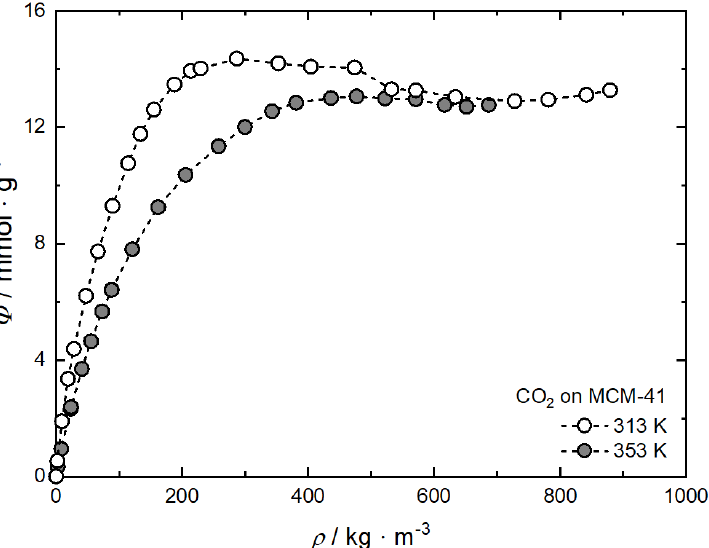
Figure 5. Adsorption isotherms of CO 2 on MCM ‐ 41 at 313 K and 353 K; experimental data are taken from [45], and the dashed lines are a guide for the